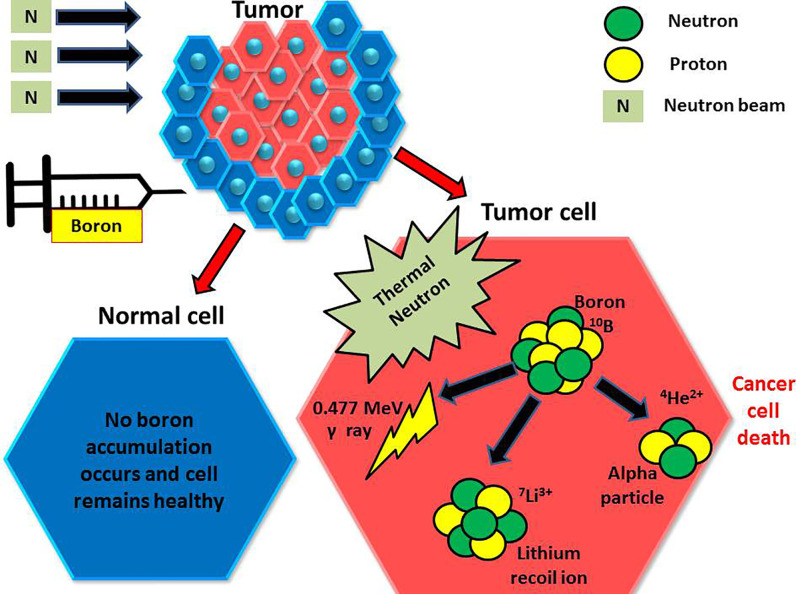
Injected boron compounds are preferentially found in tumor cells, which are then irradiated with thermal neutrons. The boron then undergoes a reaction, giving an alpha particle and an inert lithium ion. The alpha particle then damages the tumor cell with a finite range.